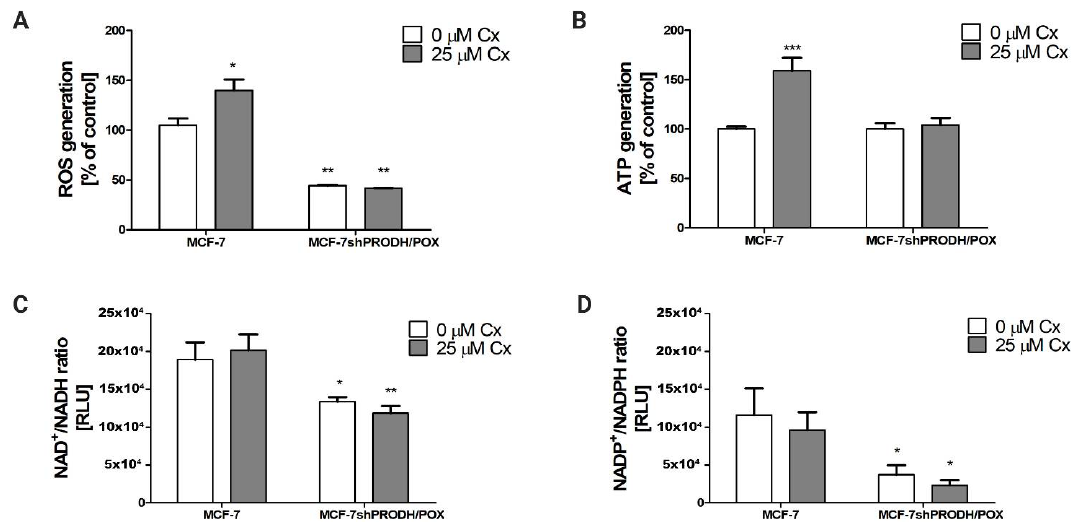
Figure 4. Celecoxib impacts on energetic metabolism in MCF-7 and MCF-7 shPRODH/POX cell lines. ( A ) ROS generation; ( B ) ATP generation; ( C ) NAD+/NADH; ( D ) NADP+/NADPH ratios after 24 h treatment of the cells with Cx. * p < 0.05, ** p < 0.01 and *** p < 0.001.